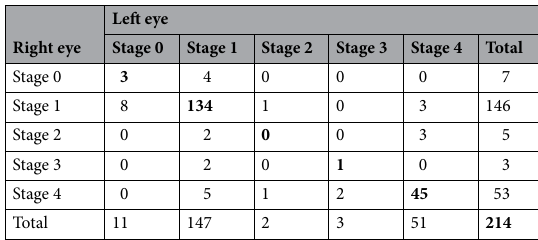
Table 2. Comparison of PVD stages in bilateral eyes. Data are presented as the number of subjects. Bold values indicate the number of subjects who had the same PVD stage in bilateral eyes. PVD posterior vitreous